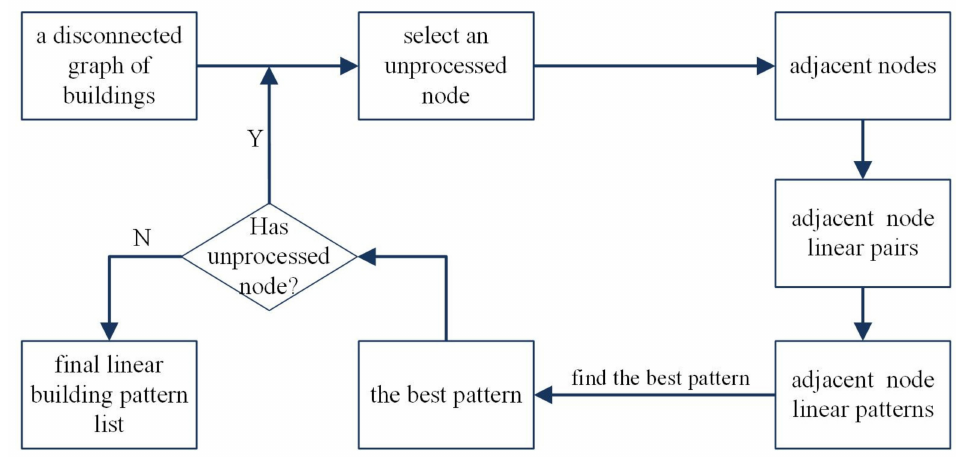
Figure 6. The flowchart for identifying linear building